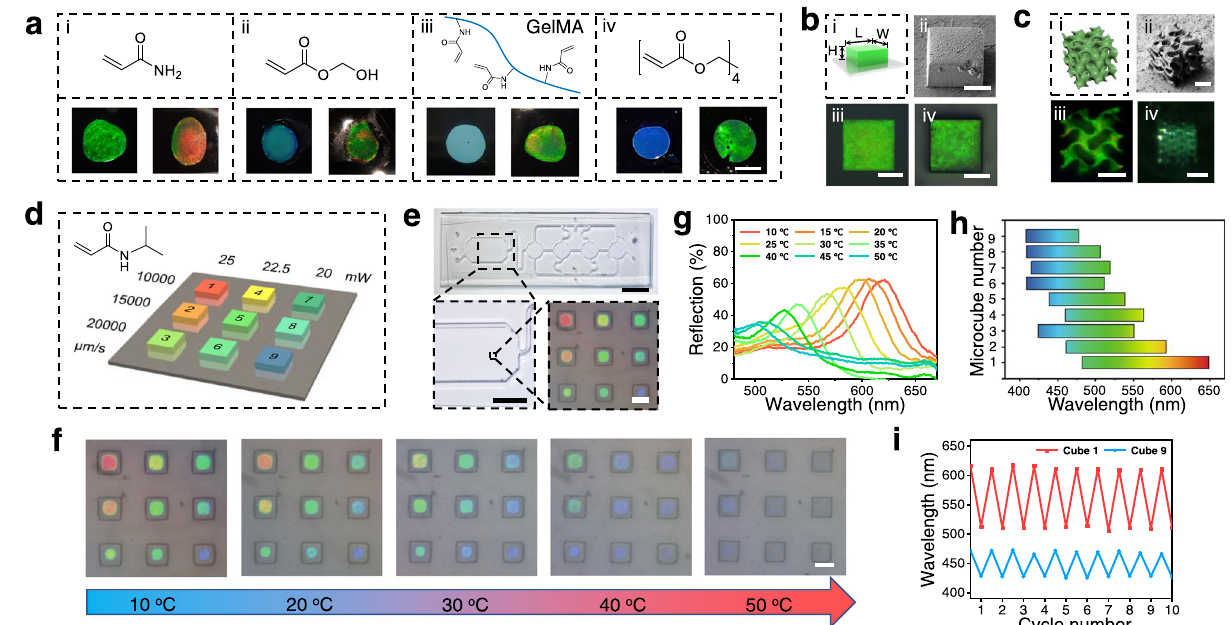
Fig. 5 | Colloidal crystal materials with various compositions generated with the sacri fi cial scaffold. a colloidal crystal hydrogel fi lms fabricated with different precursors. The upper is the structure of the monomers, and the bottom is the fabricated hydrogel fi lm (left: without sacri fi cial scaffold; right: with sacri fi cial scaffold). With the sacri fi cial scaffold, hydrogel fi lms with bright structure color were obtained in spite of the compatibility of the monomers with nanoparticles. Scale bar: 3mm. b Solid-state colloidal crystal microcube fabricated using pure PTTA as the precursor. (i) Model of the microcube (L=W=50 μ m, H=25 μ m). (ii) SEM image of the freeze-dried hydrogel microcube. (iii) Photo of the cube in DMF and(iv)inwater.Scalebars:25 μ m. c Soild-statecolloidalcrystal3Dmicrostructure